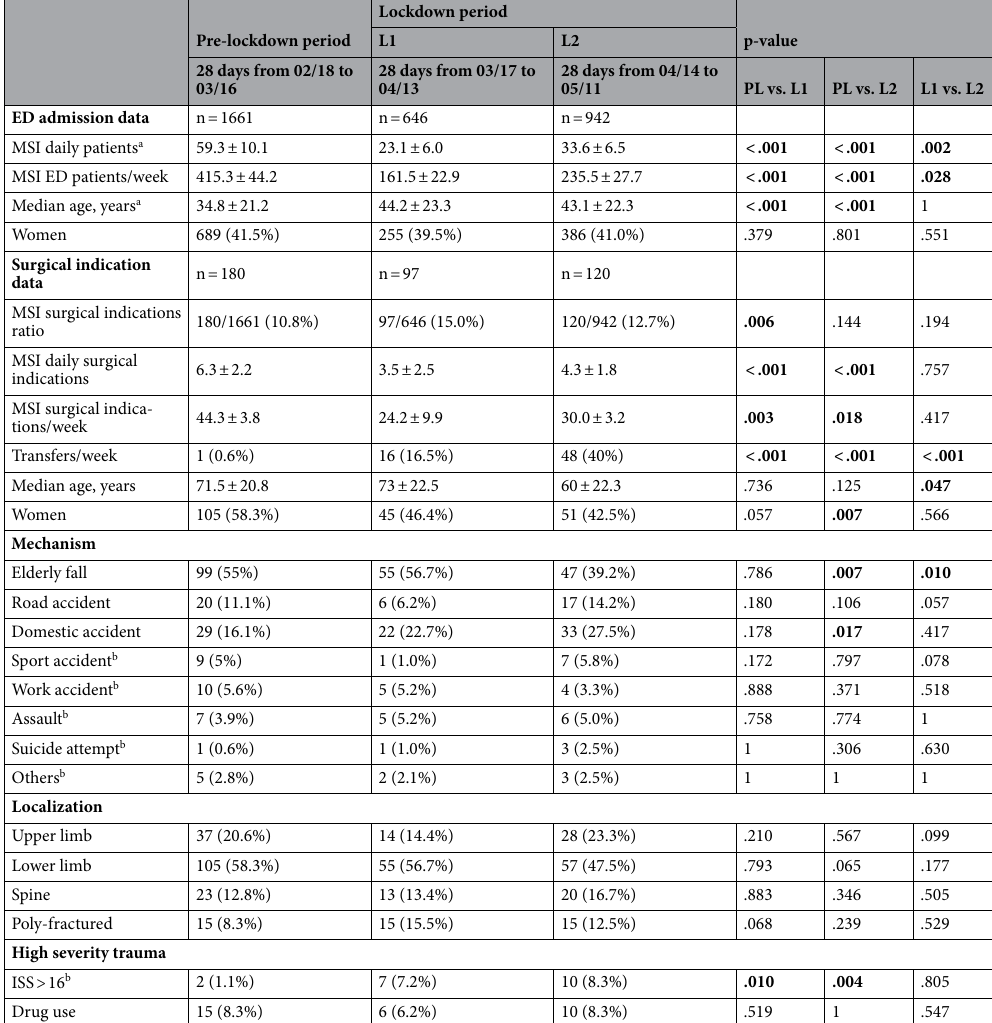
Table 1. Patient characteristics for MSI in ED admissions and MSI surgical indications.Bold values denote statistical significance at the p < 0.05 level. Chi 2 square test and one-way ANOVA test; ED: